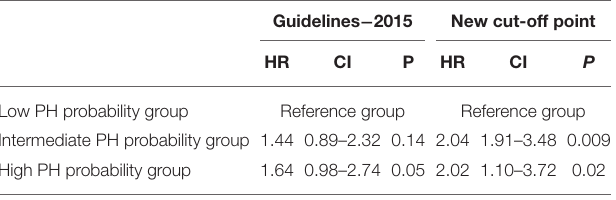
TABLE 3 | Relative risk of all-cause mortality on multivariate analysis according to ESC/ERS and the new cut-off point thresholds, in patients with tricuspid regurgitation.